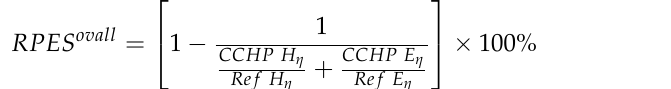
Figure 14. Monthly averaged daily operation hours for turbo chillers for Case C.